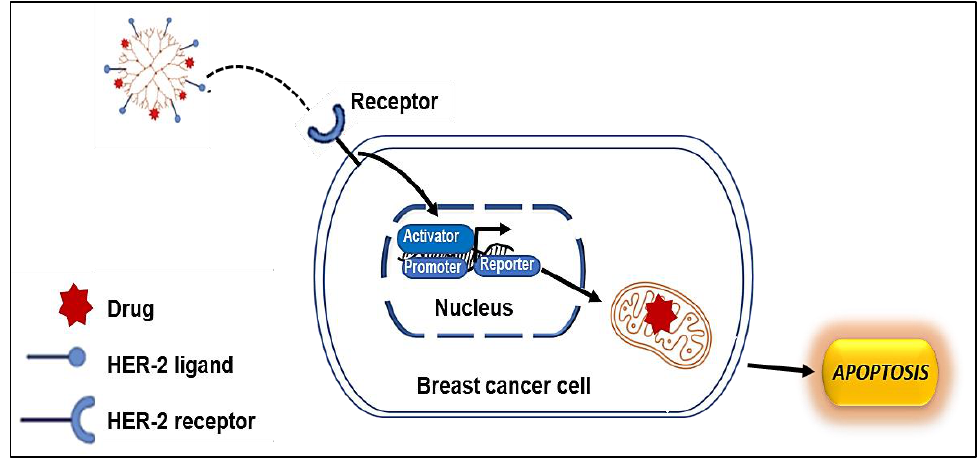
Figure 2. The cellular uptake mechanism of ligand-modified nanocarriers: the ligand-modified nanocarriers enter the cells through the primary endosome after binding to the membrane receptor, followed by the formation of an acidified endosome; later, the fusion of lysosomes ensures the enzymatic degradation of the nanoparticles.